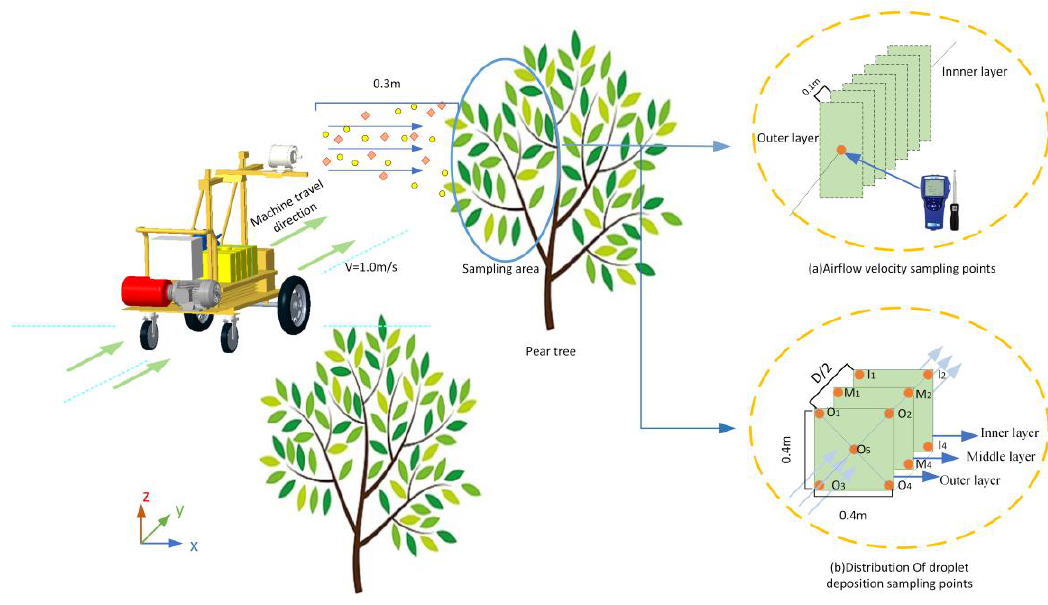
Figure 3. Map of airflow velocity measurement points within the pear canopy.